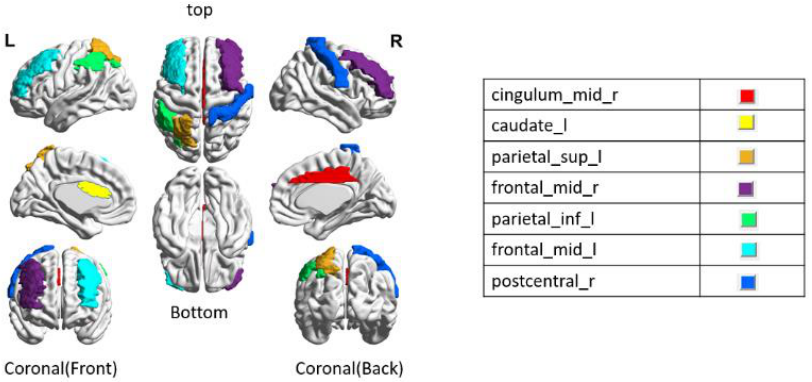
Figure 6. 7 Overlapped discriminative ROI specifications in the AAL-90 from the three AD classifi-